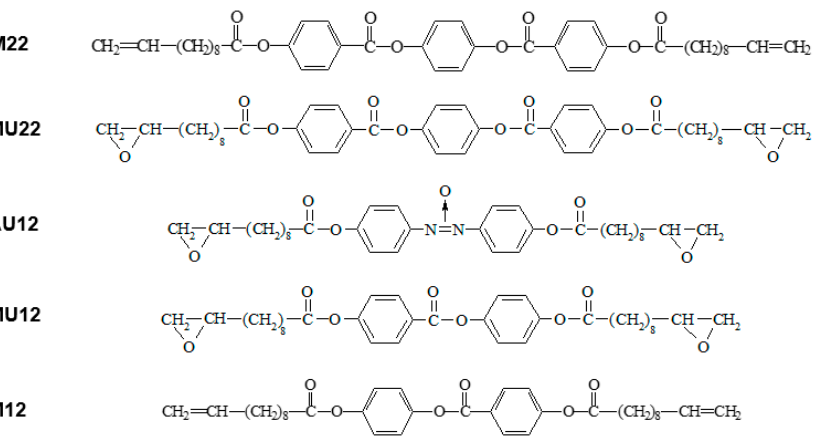
Figure 8. Molecular structure of the investigated compounds and symbols used instead of full chemical names.